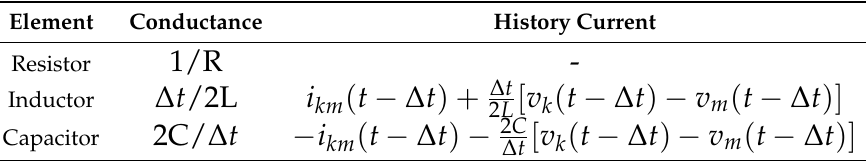
Table 1. Norton equivalents of basic elements.